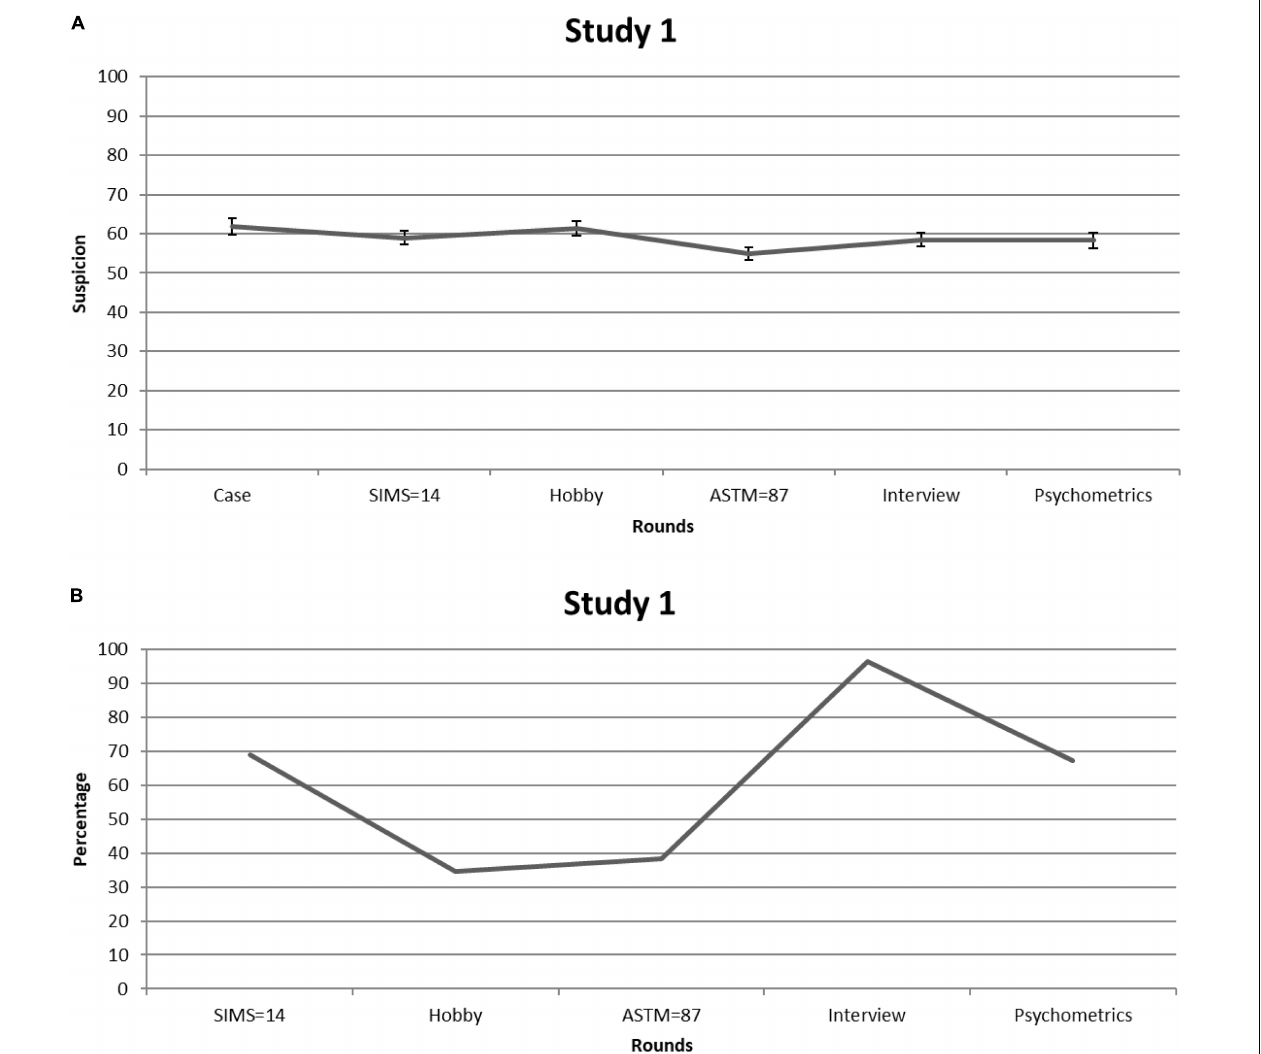
FIGURE 1 | Study 1. (A) Students’ mean feigning x confidence ratings after each round of information. Error bars are Standard Errors of the Mean. (B) Percentages of students (per round) who considered mentioning (possible) feigning as a conclusion in their